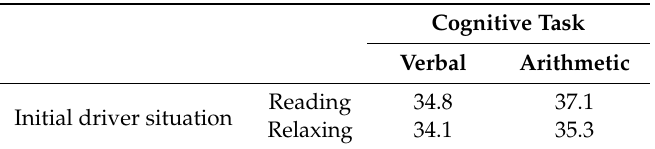
Table 2. Results of pupil size